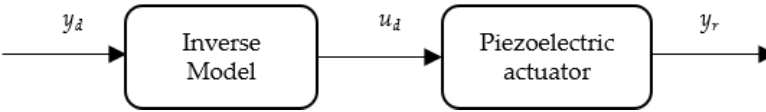
Figure 11. Schematic diagram of feedforward control.